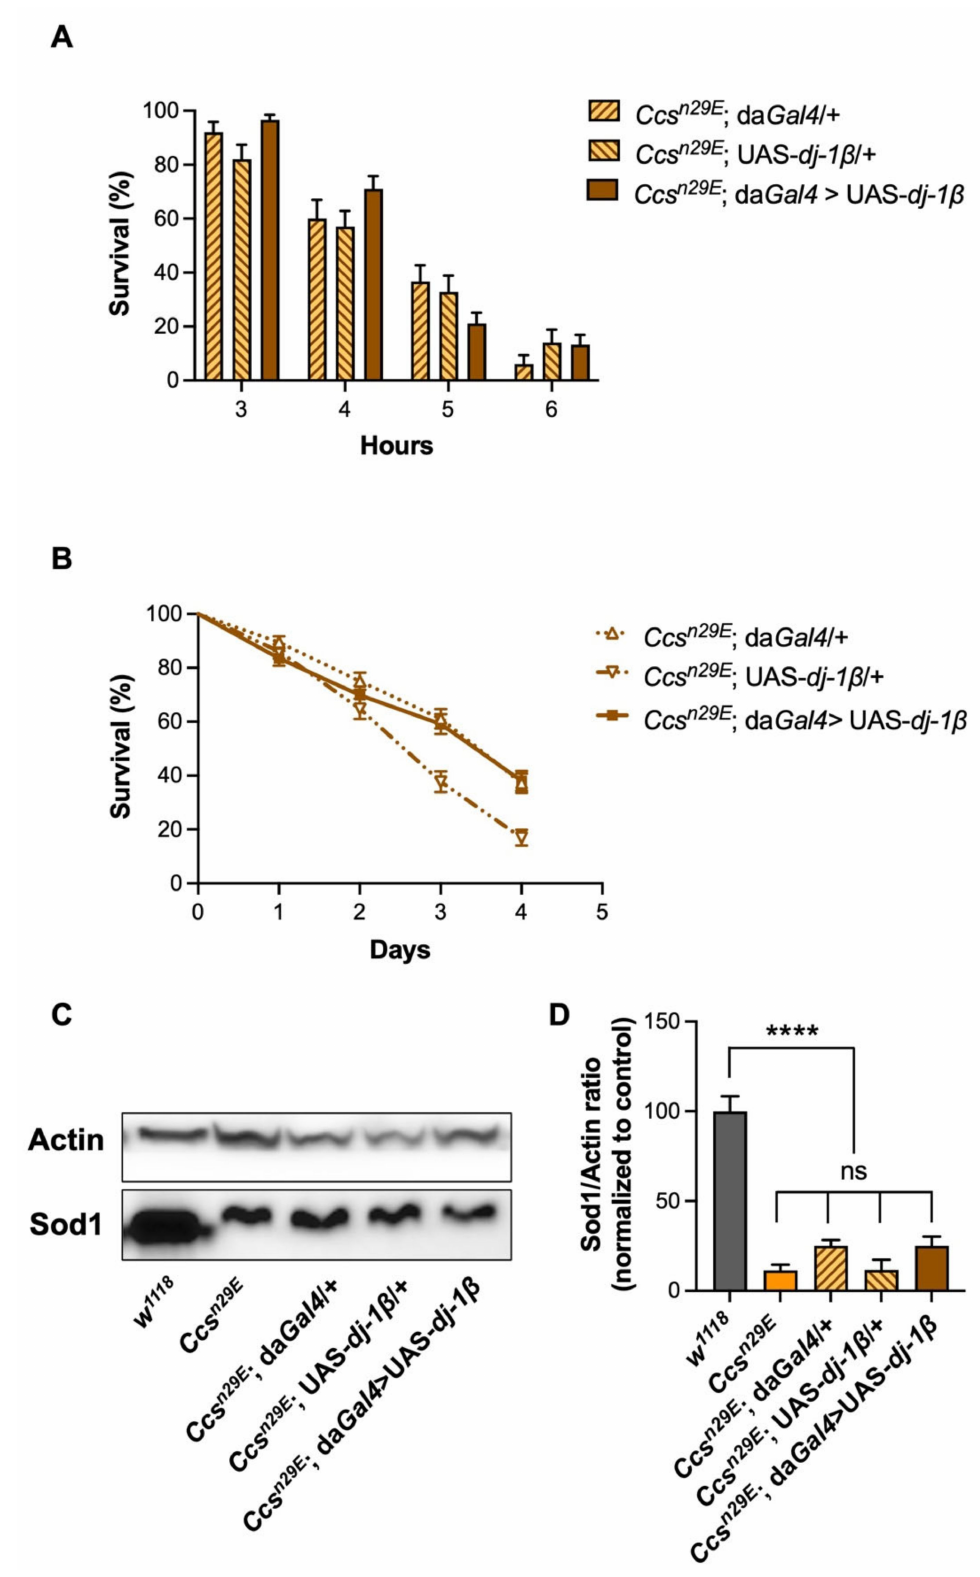
Figure 3. dj-1 β overexpression in a Ccs n29E background does not rescue the effects induced by a